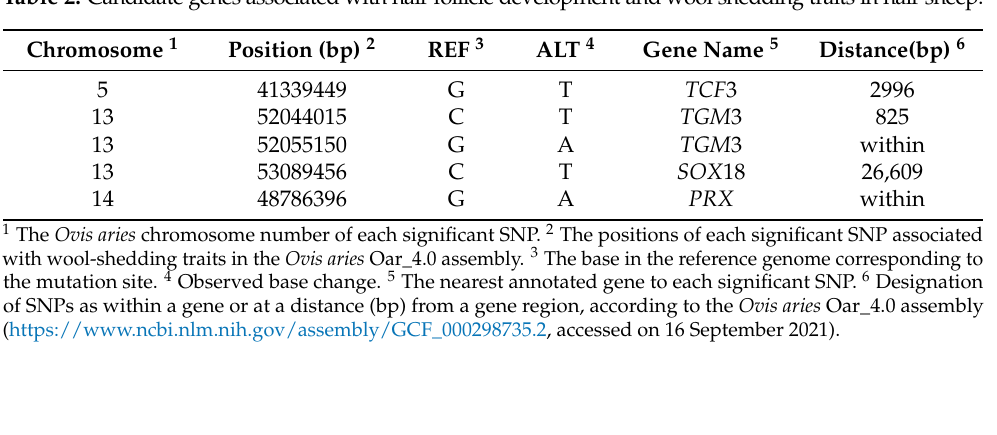
Table 2. Candidate genes associated with hair follicle development and wool shedding traits in hair